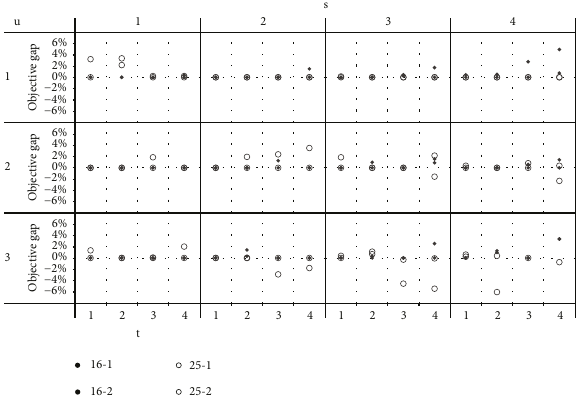
Figure 3: Objective gap between NGRASP and Benders. 16- and 25-node networks.